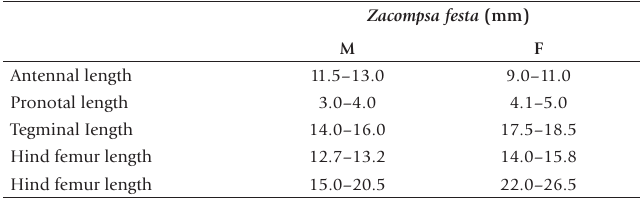
Table 12. Measurements of Zacompsa